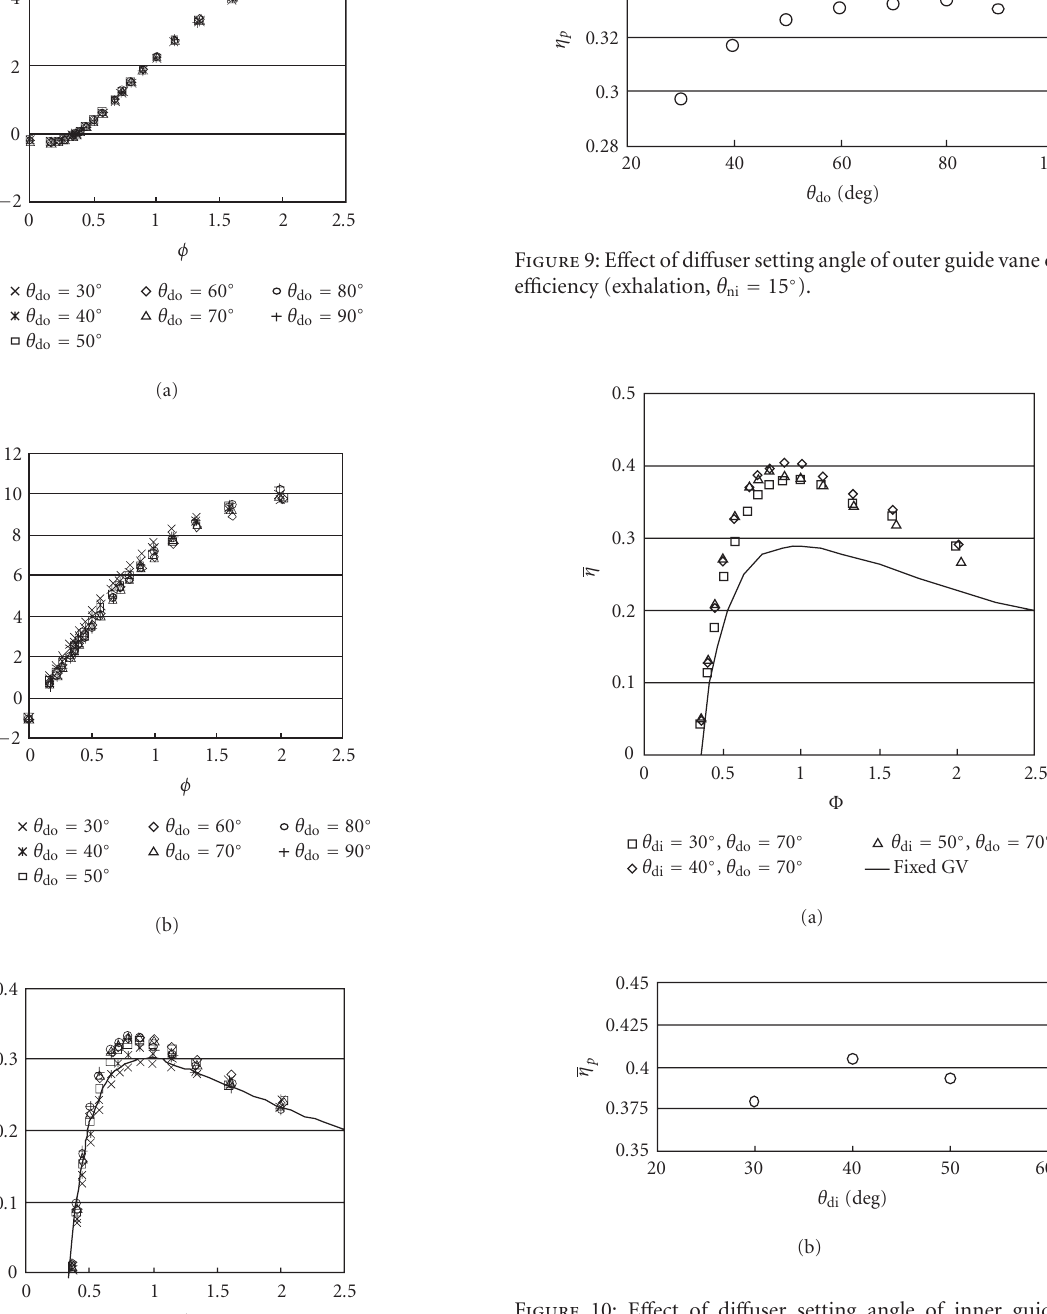
Figure 8: E ff ect of di ff user setting angle of outer guide vane on tur- bine characteristics (exhalation, θ ni = 15 ◦ ). (a) Torque coe ffi cient. (b) Input coe ffi cient. (c) E ffi ciency.